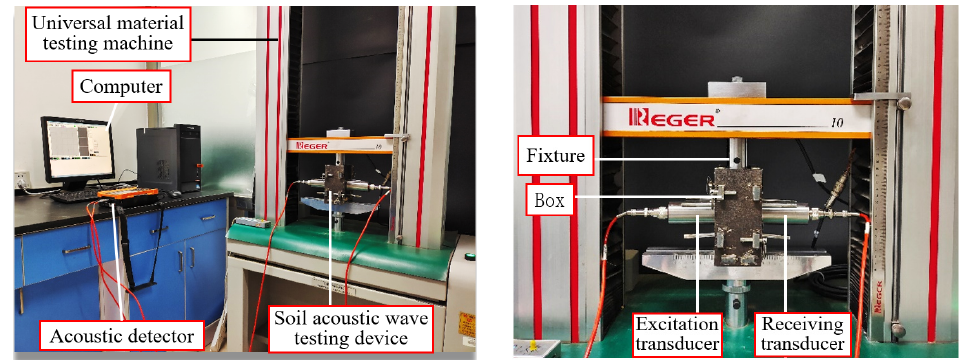
Figure 1. Acoustic − soil test